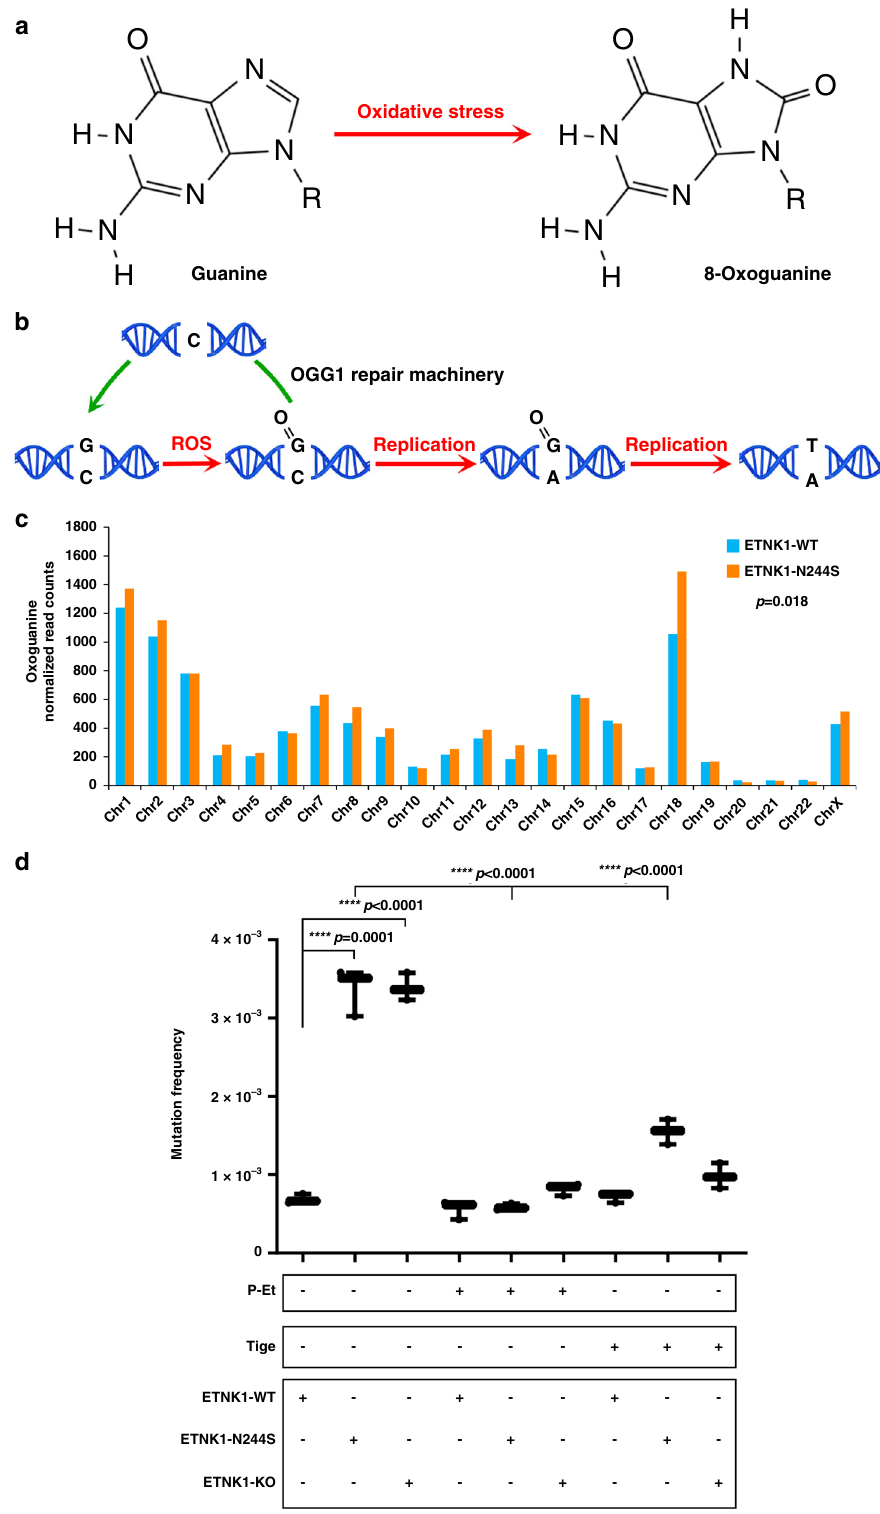
a well-known marker of DNA DSBs 23 , by confocal microscopy. Comparison of ETNK1-N244S and ETNK1-WT lines revealed a sharp increase in the number of γ H2AX foci (Fig. 5a, c; 2.52 fold increase; p = 0.0002) in the former. Similar results were achieved in the presence of ETNK1-KO (Fig. 5a – c; 2.51 fold increase; p = 0.0002), indicating that the suppression of ETNK1 activity and the ensuing decrease in P-Et intracellular concentration are